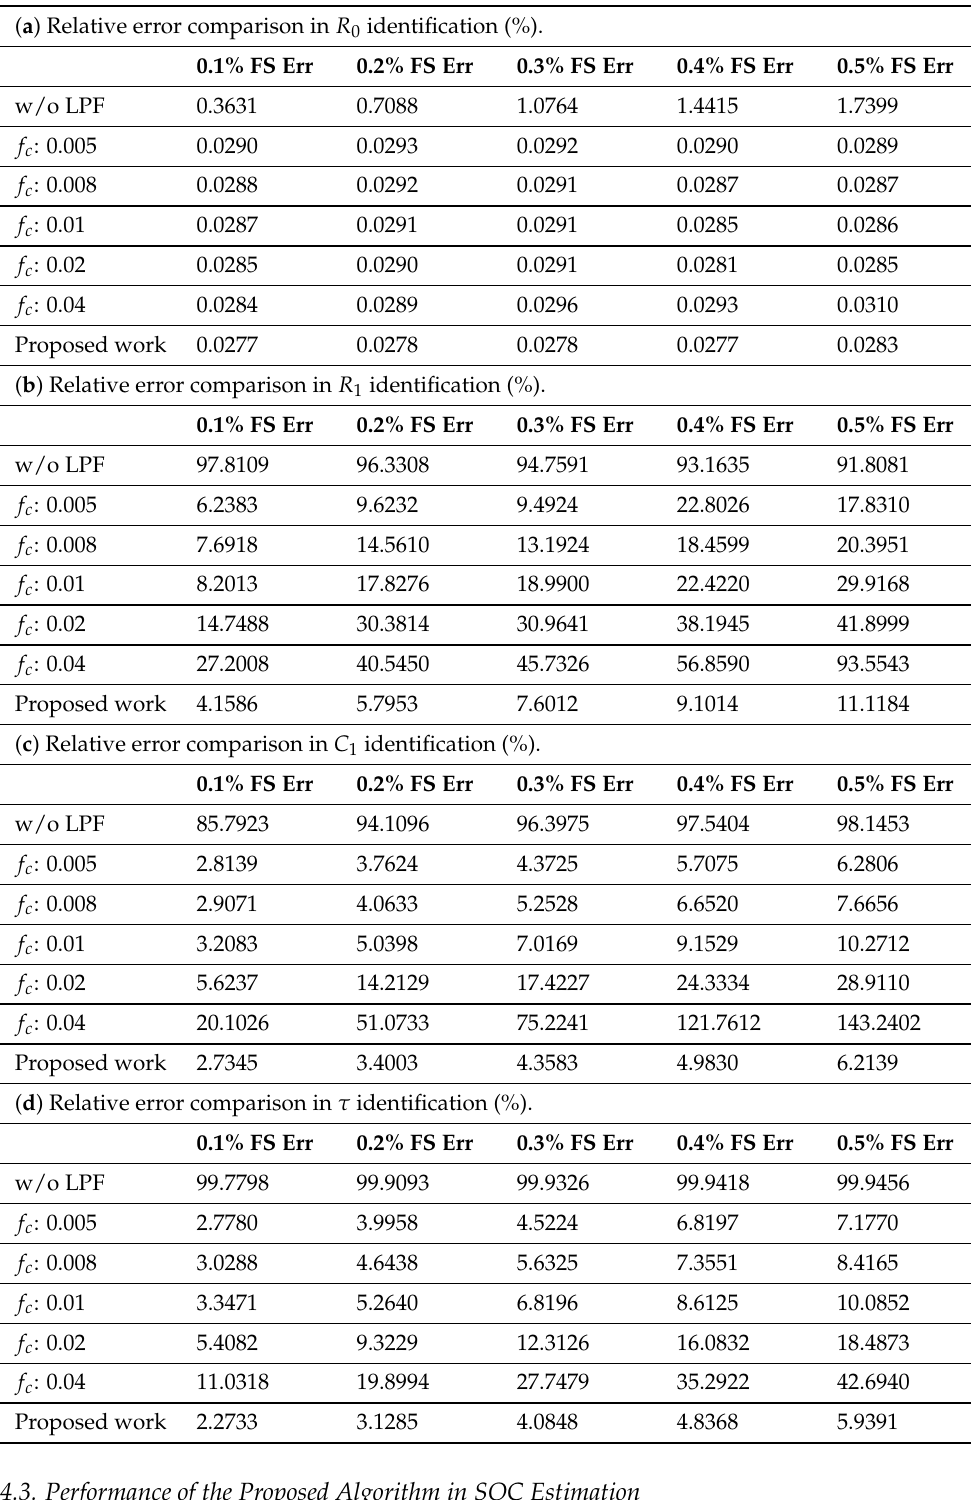
comparison using multiple cutoff frequency design in cases of various scale